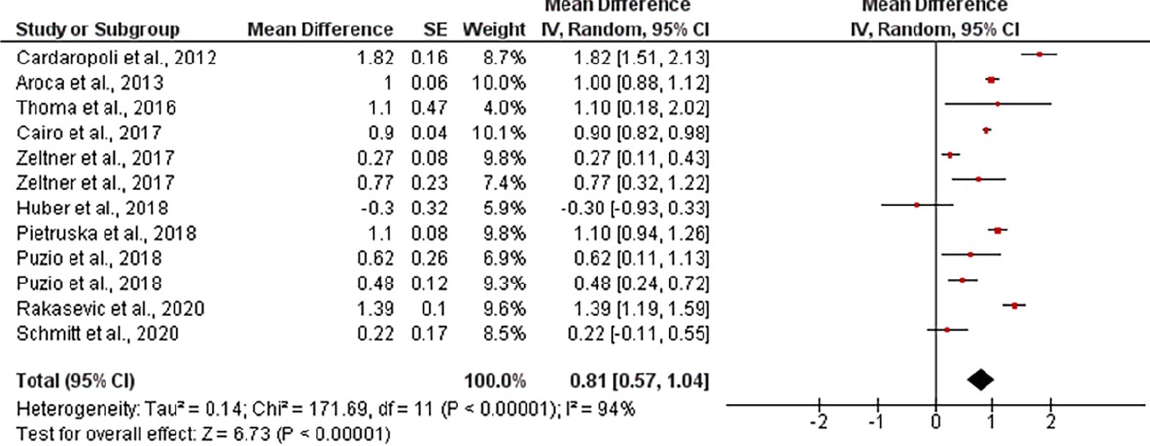
Figure 11. ( a ) Funnel plot for gingival thickness in control group (autogenous connective tissue). The estimated gingival thickness measurement is on the horizontal axis and the study precision (standard error) appears on the vertical axis. ( b ) Funnel plot for gingival thickness in the test group (collagen matrix). The estimated gingival thickness measurement is on the horizontal axis and the study precision (standard error) appears on the vertical axis. Figure 12. Forest plot for gingival thickness. Test (collagen matrix) vs. control (autogenous connective tissue) groups. The weighted mean is presented at CI 95%. Heterogeneity was determined using Higgins (I 2 ). A random-effects model was applied. Statistical significance was p < 0.001.